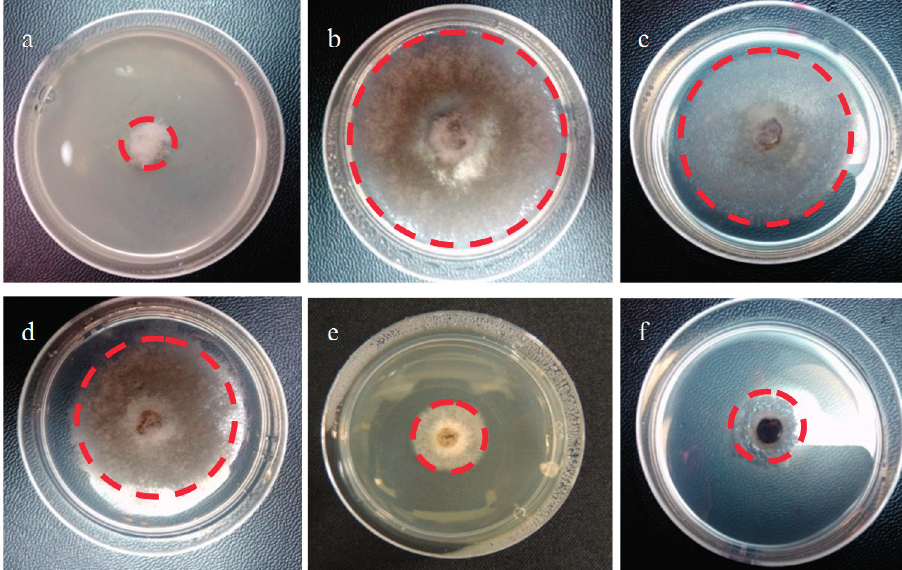
Figure 8. Effect of geranylated phenol/phenyl acetate derivatives on in vitro mycelial growth of B. cinerea . ( a ) Positive control, Captan; ( b ) negative control, the medium contains only PDA and 1% ethanol; ( c ) compound 15 ; ( d ) compound 6 ; ( e ) compound 9 ; ( f ) compound 17 . Concentration of Captan and all tested compounds is 250 mg/L. The red line gives the growth radius of the negative control ( b ) and in presence of different